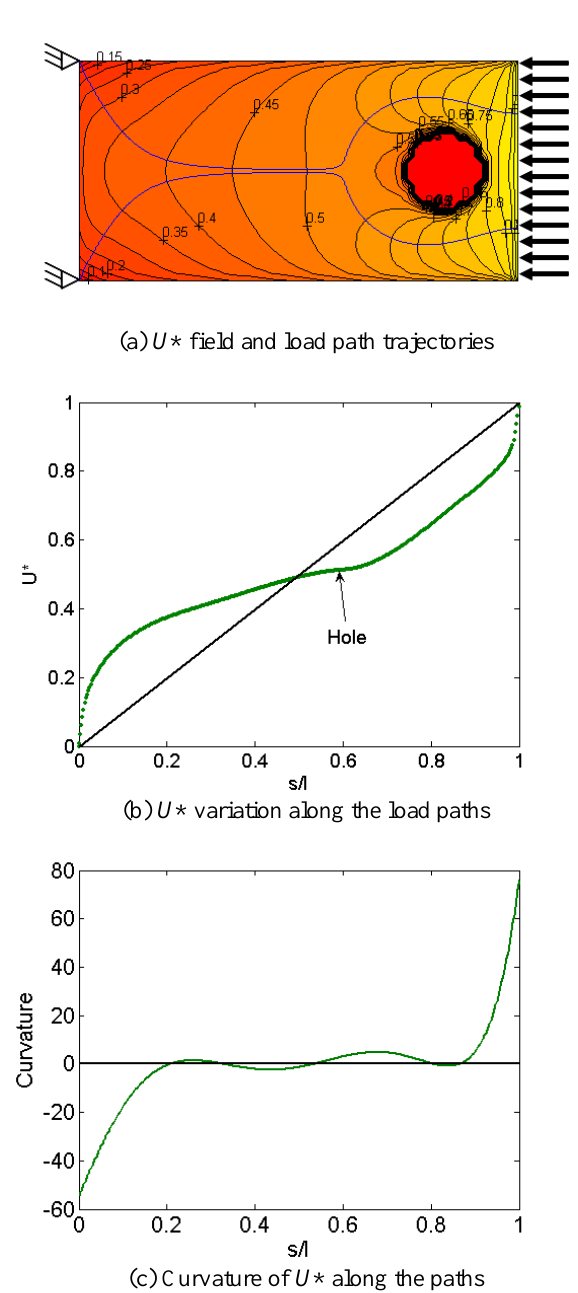
Fig. 28. Load paths based on U * for rectangular structure with a hole and distributed loading in the